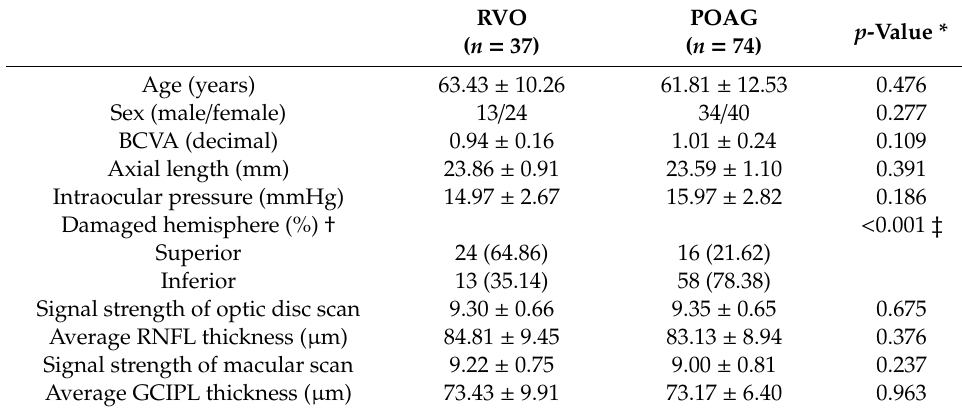
Table 1. Demographics of patients with retinal vein occlusion and primary open-angle glaucoma.